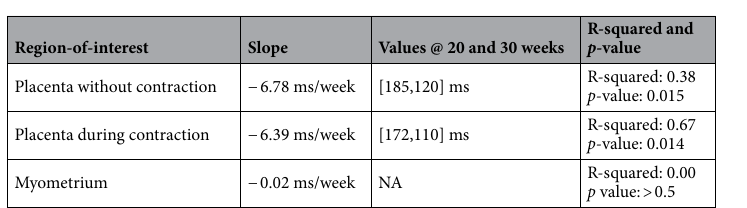
Table 3. Overview over the statistical results for the correlation between mean T2* and gestational age [ms].